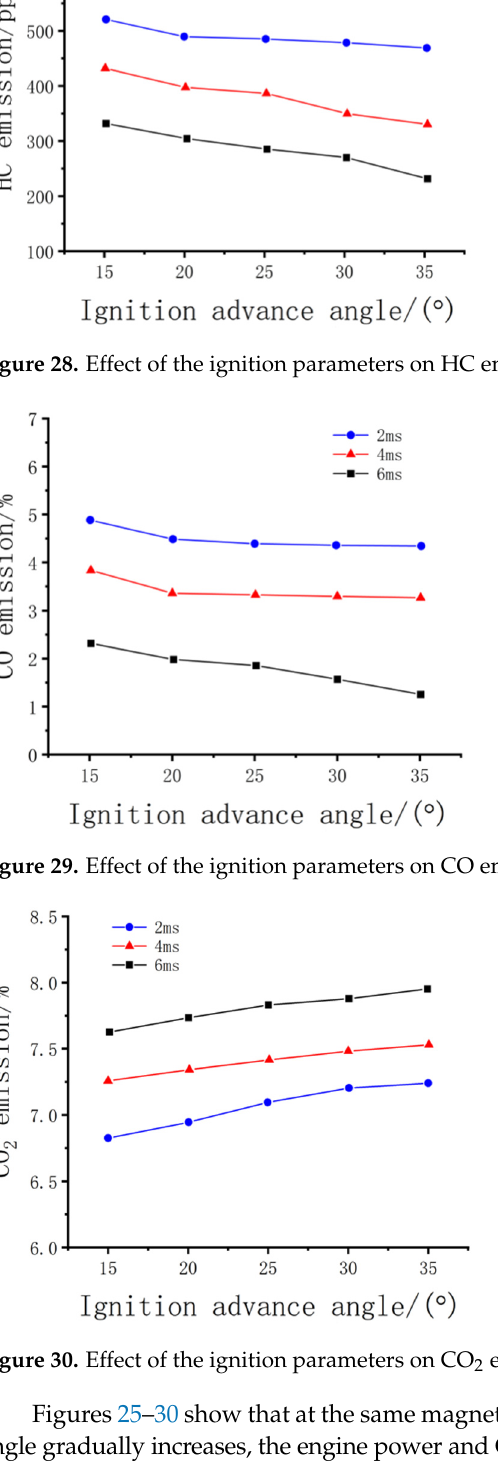
Figure 27. Influence of the ignition parameters on exhaust temperature.